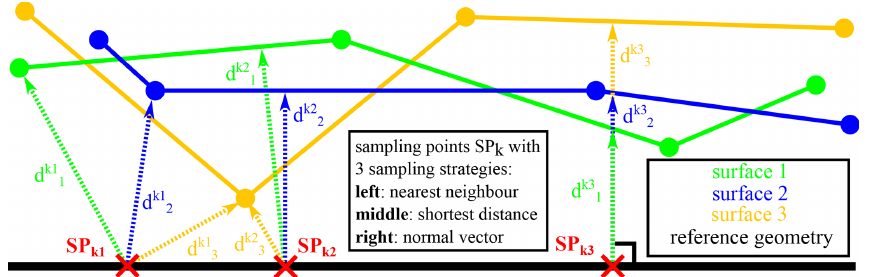
Figure 1. Visualization of the different sampling strategies nearest neighbour (left), shortest distance (middle) and normal vector (right) (Müller and Hausotte, 2019a).